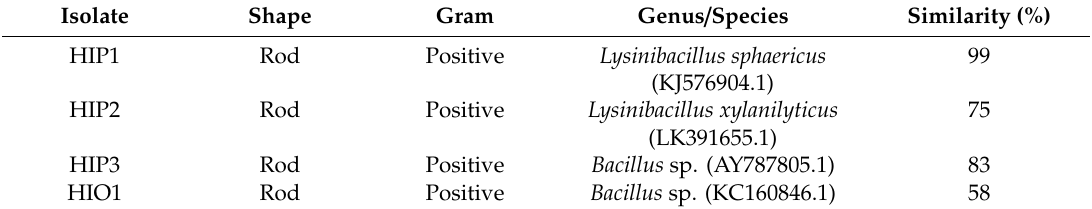
Table 3. Gram staining and identification of the bacterial isolates by 16S rRNA gene sequence analysis.